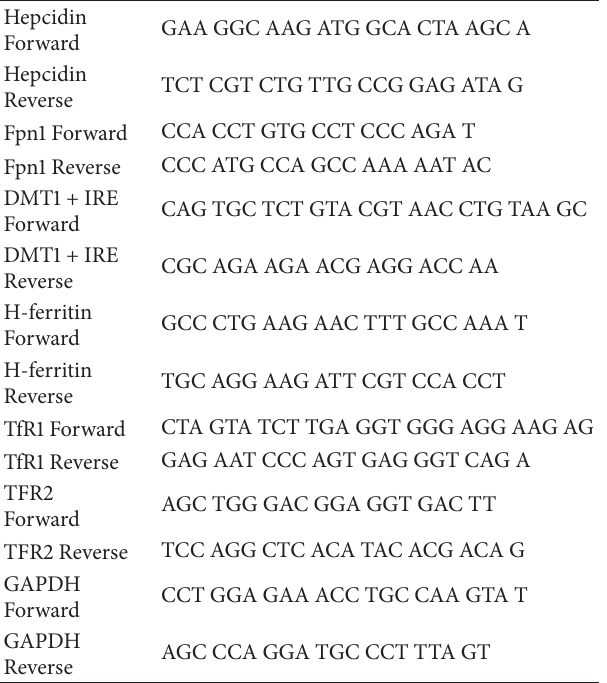
Table 2: Summary of the primers for iron-related gene